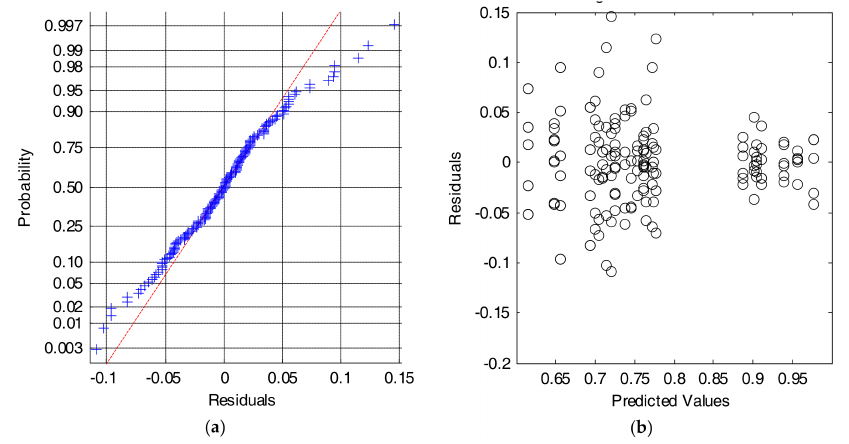
Figure 10. Results for the SVM algorithm. Analysis of the residuals: ( a ) Normal probability plot (crosses: empirical data, dashed line: theoretical normal fit); ( b ) Values of the residuals versus the predicted (or fitted)